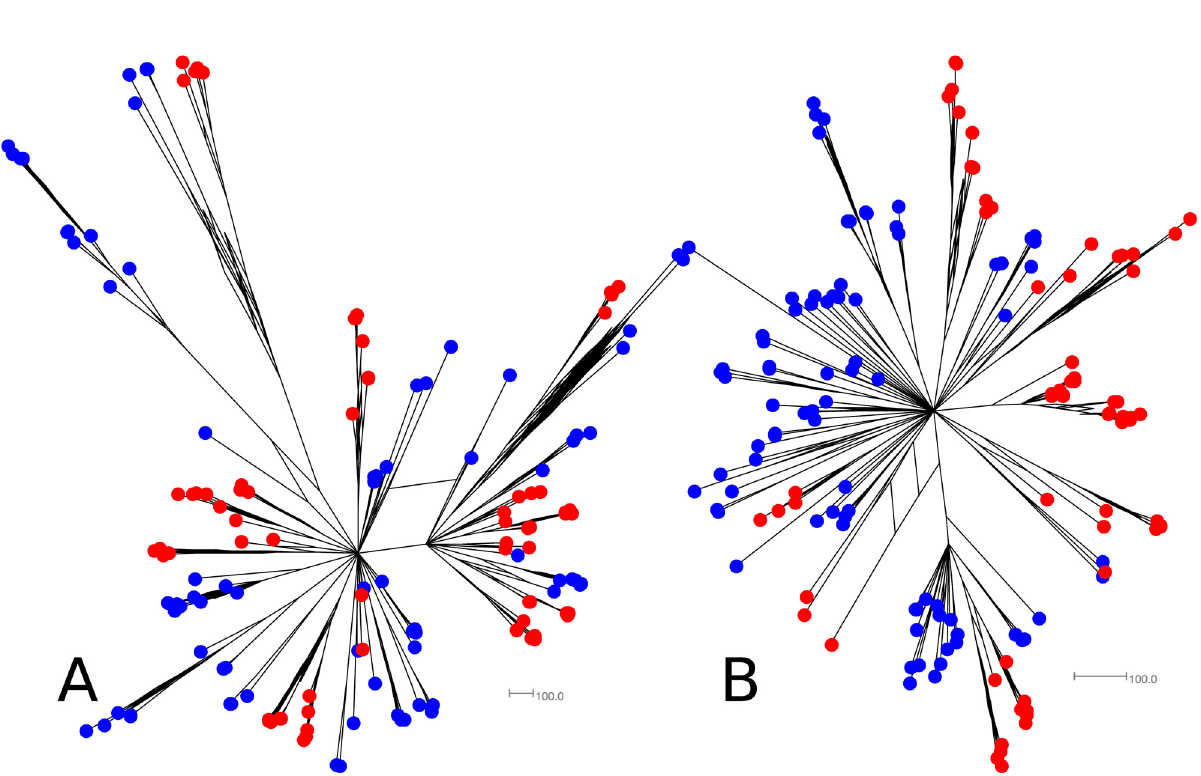
Fig 5. Consensus networks based on the posterior sets of trees for PI family 2. E2 (A) and NS5B (B) sequence alignments were evaluated independently. F2-G1 tips are blue and F2-G2 tips are red.